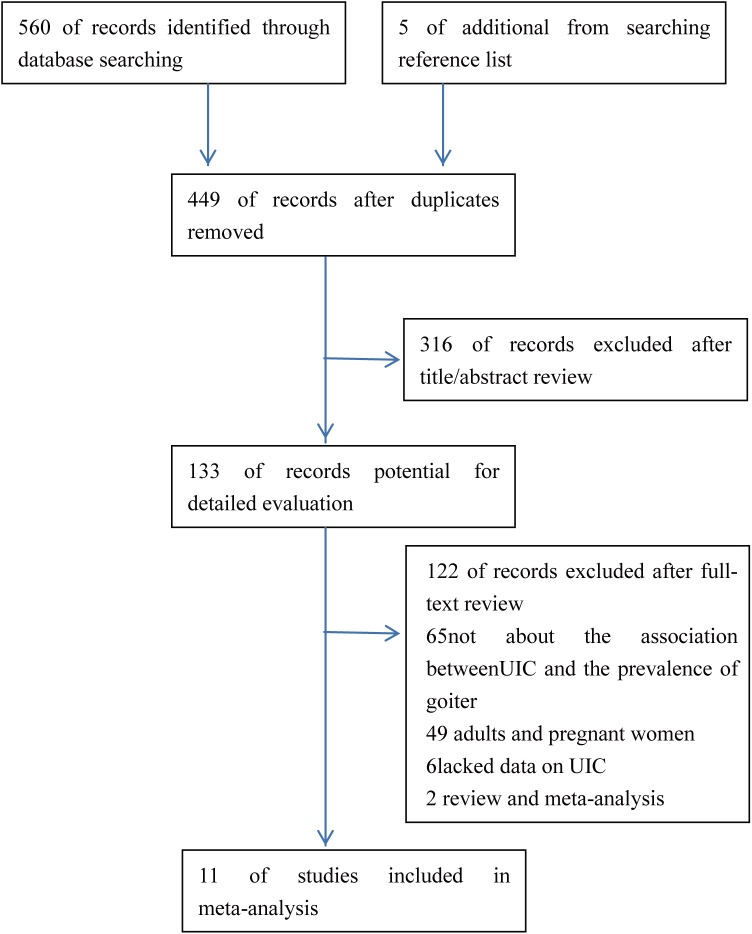
Flow diagram of the study selection process.